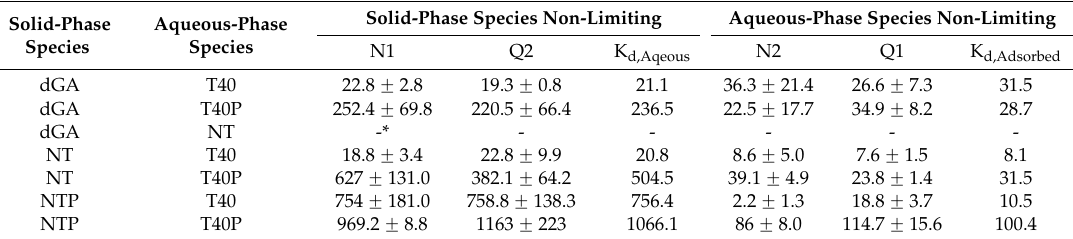
Table 2. Saturation aqueous- and solid-phase binding constants (nM) for tau-tau binding. Solid-Phase